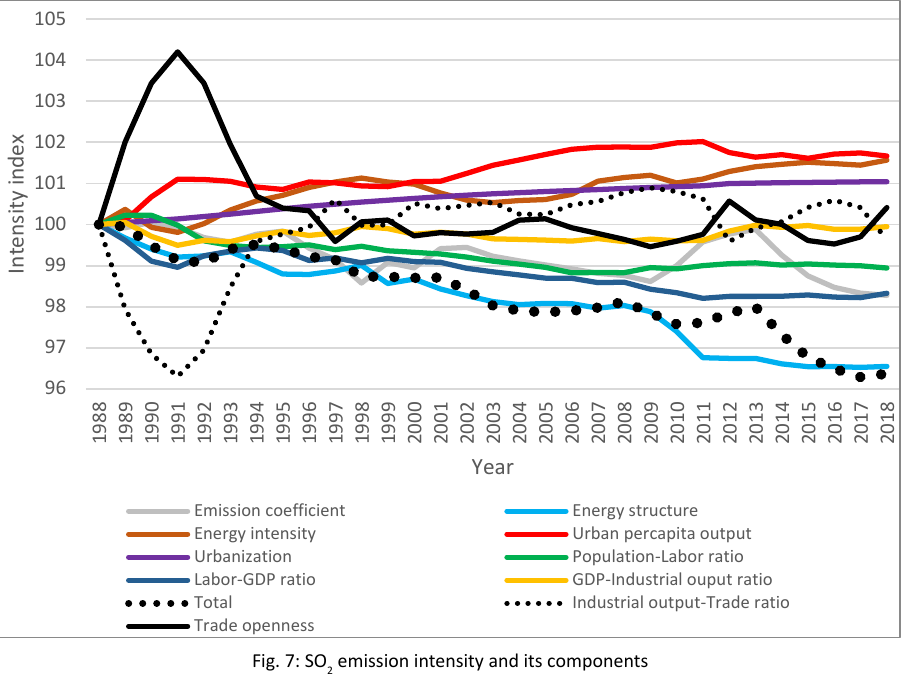
Fig. 7: SO emi ssion intensity and its components 2 Fig. 7: SO 2 emission intensity and its components